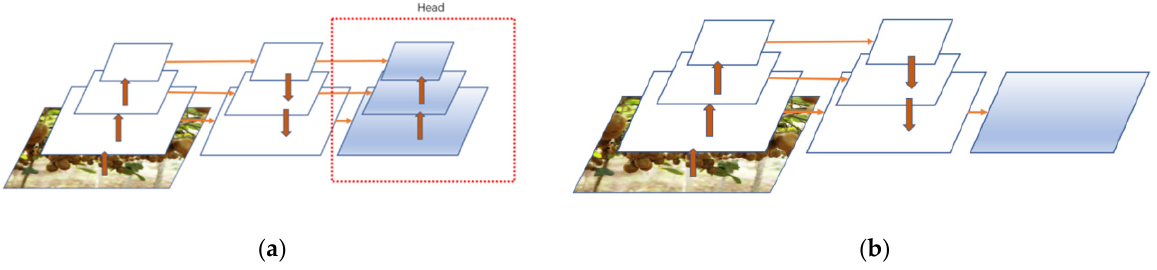
Figure 7. ( a ) Original YOLOX feature fusion structure and ( b ) improved structure, in which only the 80 × 80 feature map structure is preserved.